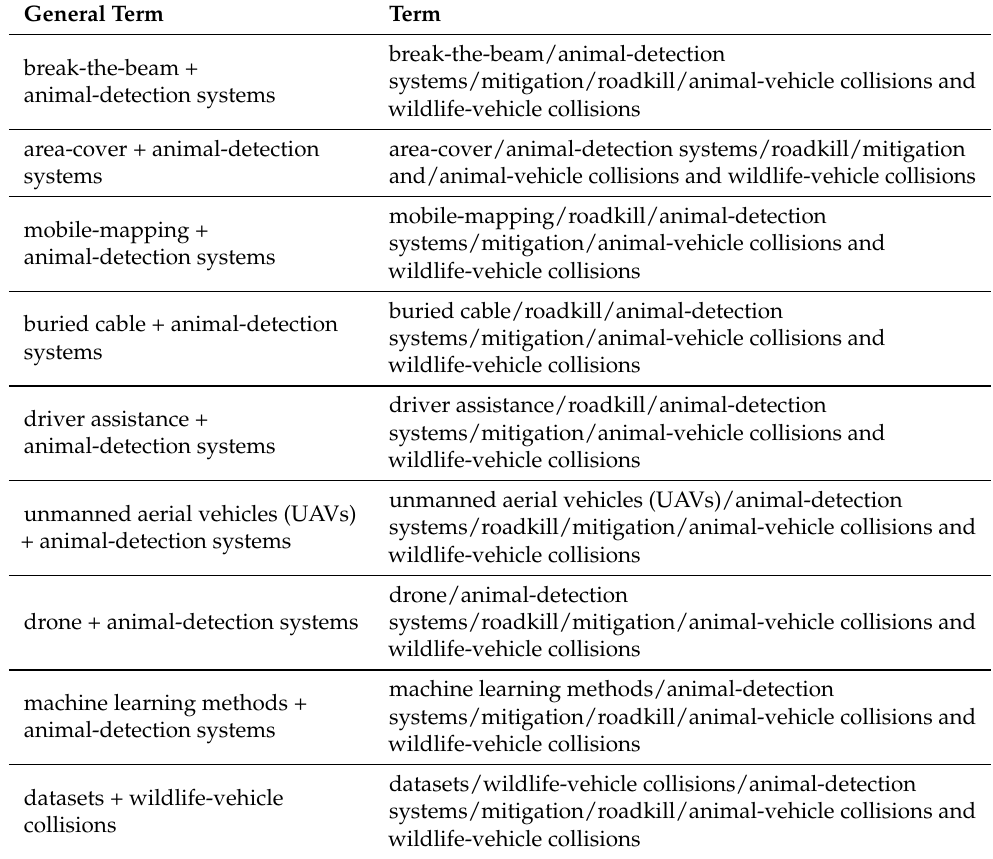
Table 2. Search terms used when retrieving manuscripts from the different internet sources. General Term